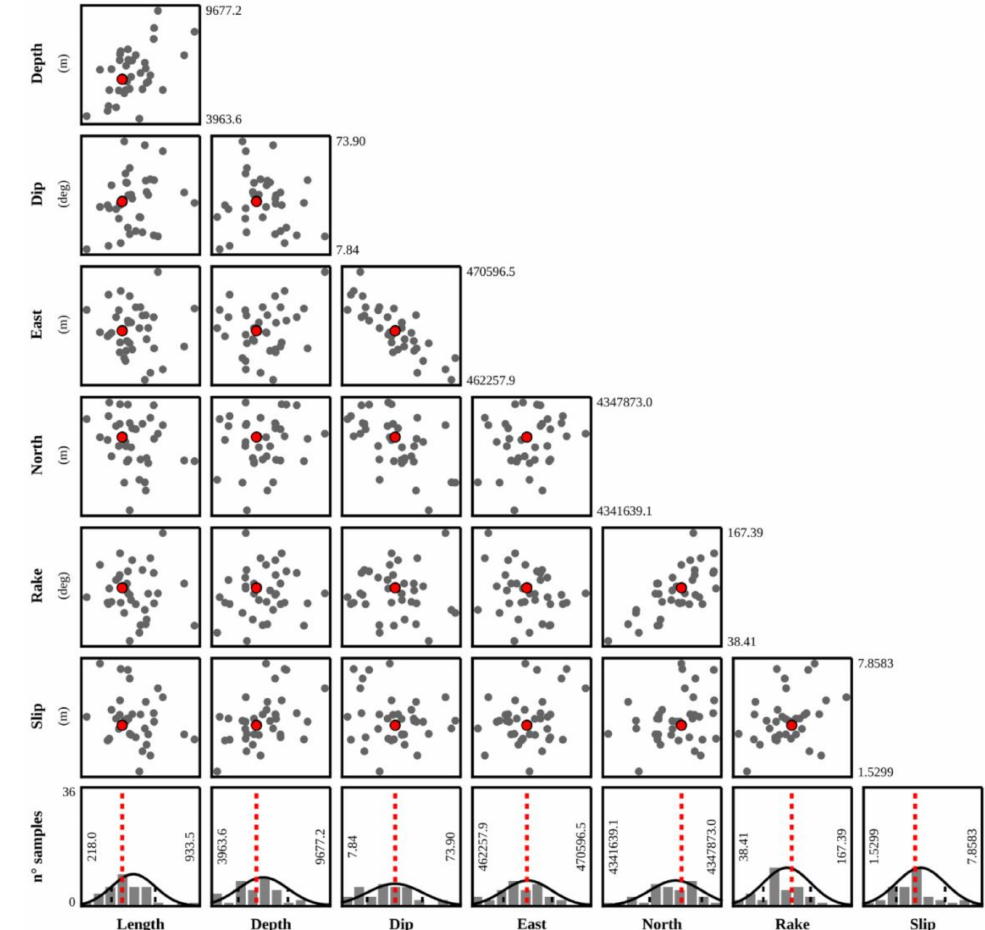
Figure 4. InSAR non-linear inversion statistics and trade-offs for an east-dipping fault. The scattered plots are showing the potential trade-offs between the various parameters. Red points are the optimal parameters in each case. Bottom histograms are the a-posteriori probability distributions of the parameters. Bell curves are indicating the Gaussian